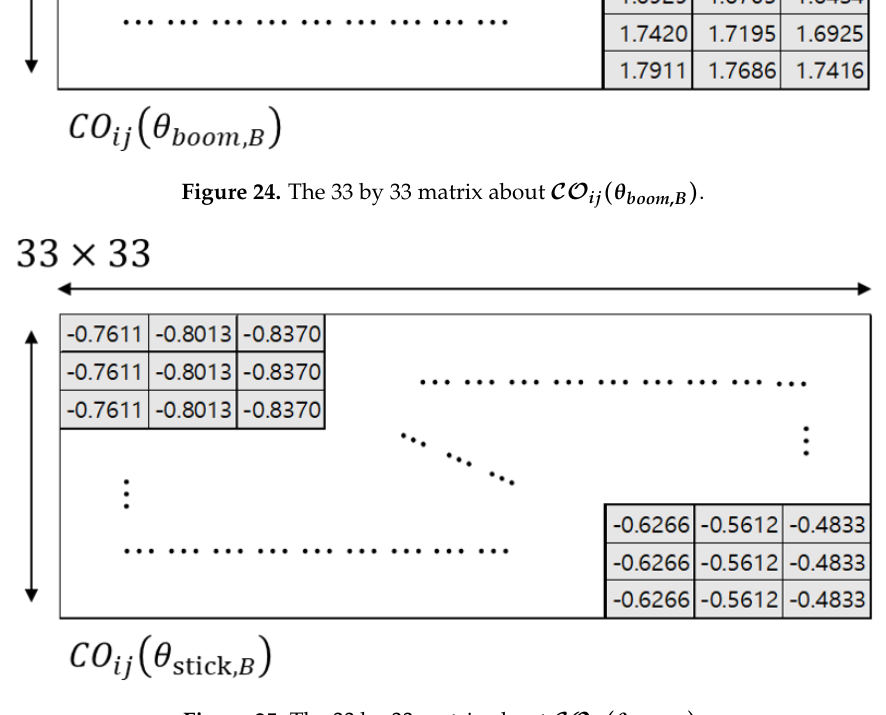
Figure 25. The 33 by 33 matrix about CO ij ( θ stick , B ) .